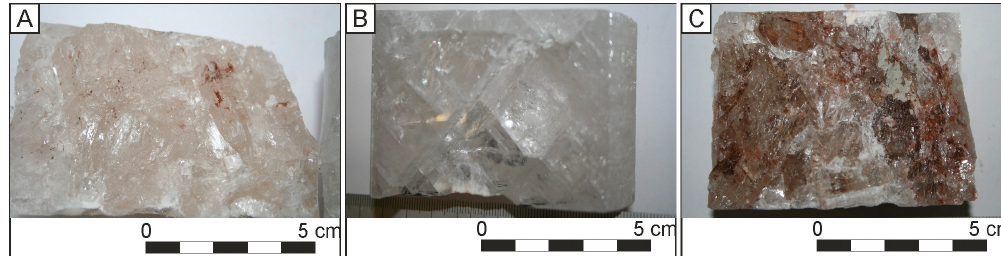
Figure 3. Lithological types of the Lotsberg Salt Formation: ( A ) large crystalline salt rocks with large halite crystals containing small amounts of impurities (depth − 1291.8 m a.s.l.). ( B ) Clean and very large halite crystal (depth − 1191.2 m a.s.l.). ( C ) Large crystalline salt rocks with a large number of impurities (depth − 1193.8 m a.s.l.).